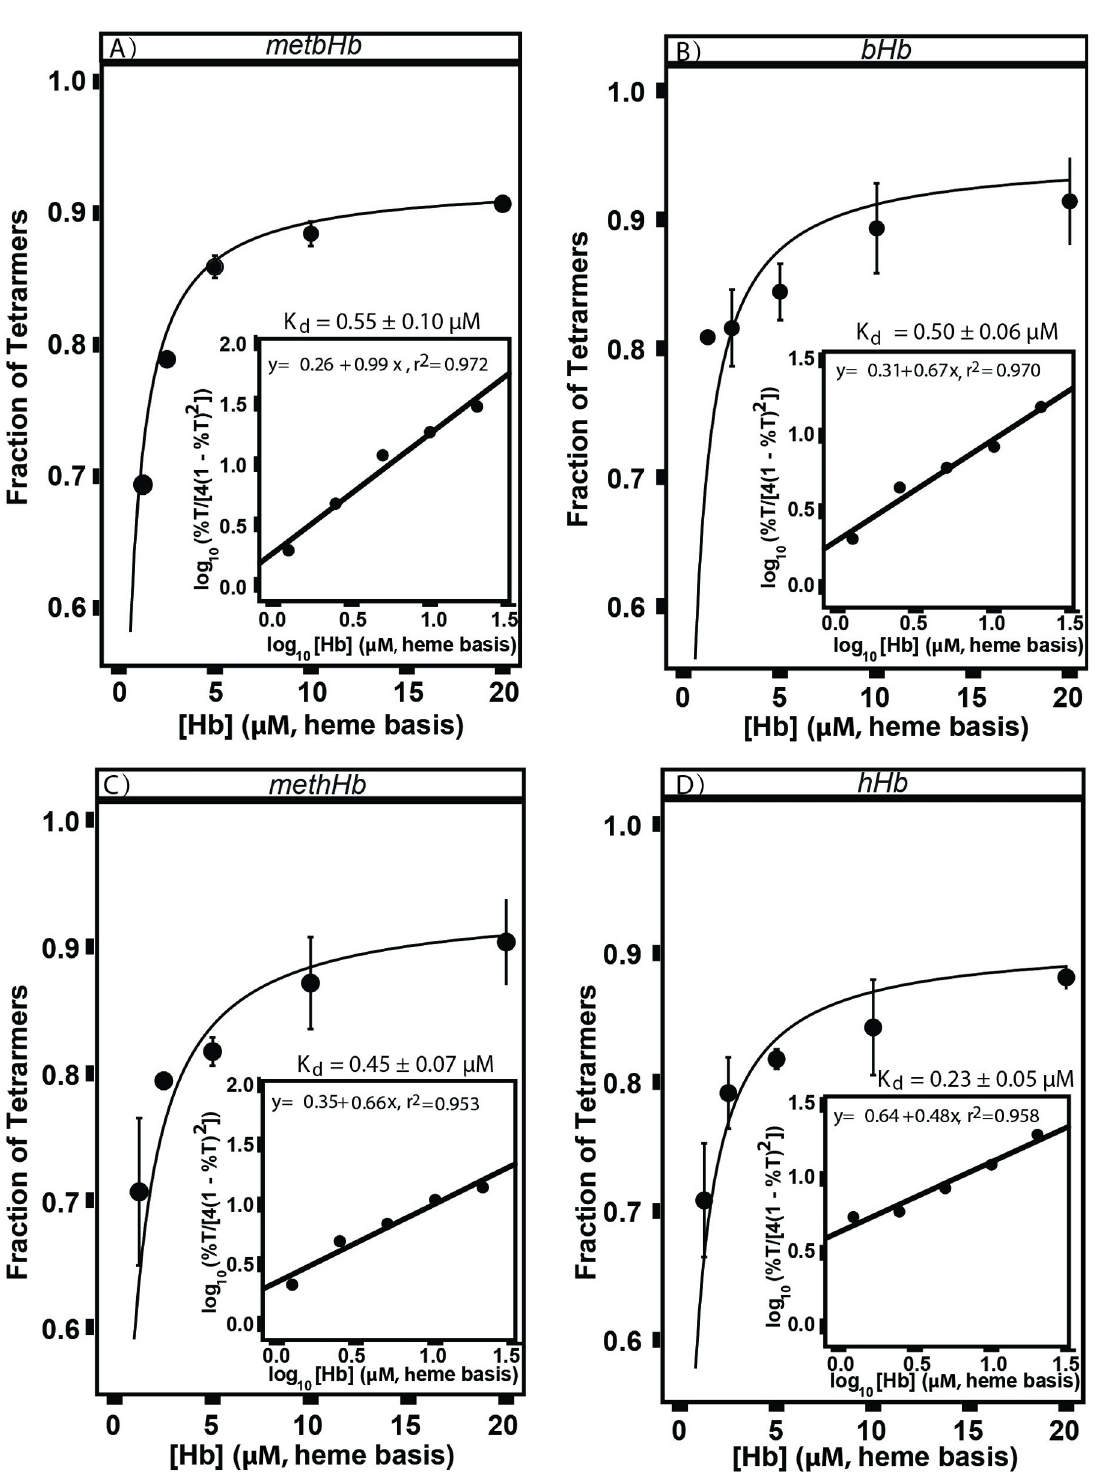
Fig 8. Equilibria between dimers and tetramers of (A) metbHb, (B) bHb, (C) methHb, (D) hHb. The tetramer-dimer dissociation constant (K d ) shown in each figure inset was calculated as described in the text. All samples were incubated in PBS (0.1 M, pH 7.4) and analyzed on a Thermo Scientific Dionex UltiMate 3000 UHPLC/HPLC system coupled with an Acclaim SEC-1000 column. Deconvolution analysis was then performed on the chromatogram of all samples to yield the fraction of Hb tetramers. (The error bars represent the standard deviation from 3 replicates; the regression performance was evaluated with the R-squared (R 2 ) value.)